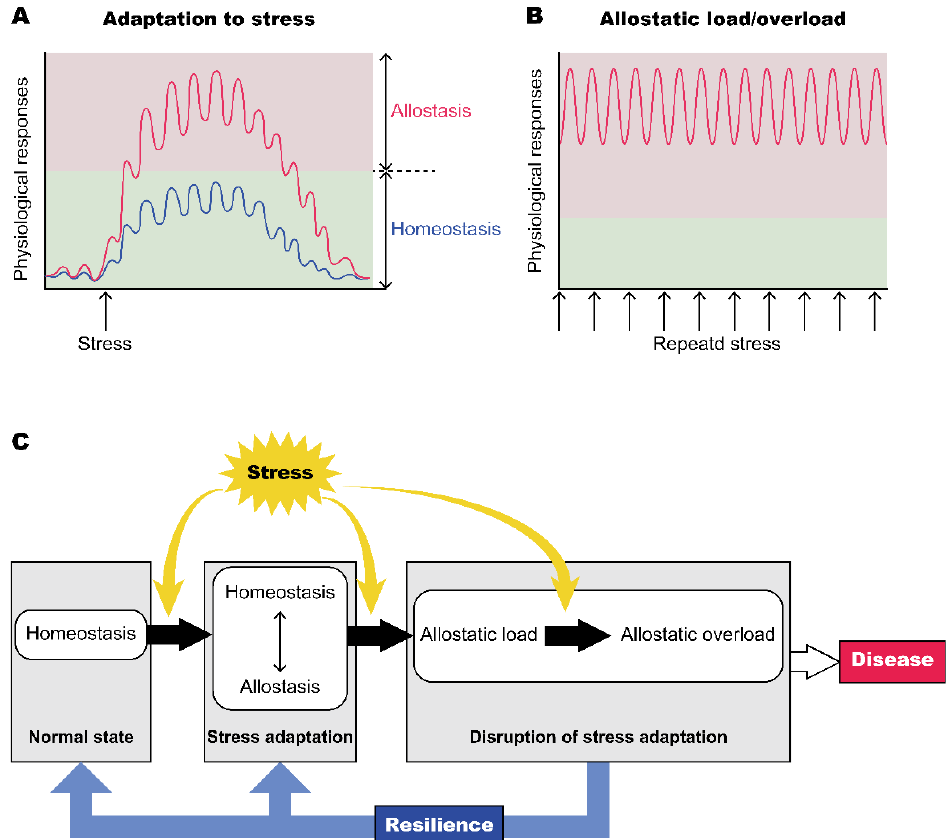
Figure 1. Allostasis and resilience. ( A ) Physiological responses to stressful stimuli in bodily systems including the autonomic nervous system, hormone responses, and inflammatory cytokines. Homeostasis refers to the body’s ability to maintain a stable internal milieu. Allostasis refers to the process that maintains homeostasis and to the drive of other physiological and behavioral systems by changing set points depending on changing environments. A normal allostatic response lasts for an appropriate time after stress, then returns to a normal level and ends [7]. ( B ) Allostatic load/overload is a state of chronically sustained allostasis that is induced by chronic stressful stimuli or inefficient management of allostasis. Allostatic load is also provoked by repeated normal responses over time, lack of adaptation, prolonged responses due to delayed shutdown and inadequate responses [7]. ( C ) Allostatic load or overload persistently activates physiological responses (neuroendocrine, cardiovascular and emotional responses) and accelerates the progression of various diseases. Resilience acts to restore physical and psychological conditions from a failed state of allostasis to a normal